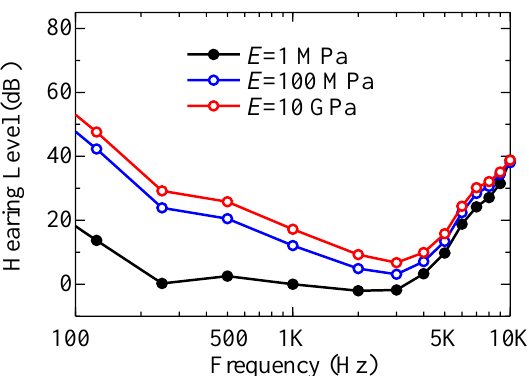
Figure 10. Estimation of the hearing level of the whole auditory system, including the properties of the outer, middle, and inner ears, when the ear is healthy. The upper graph shows the sound pressure level at the oval window when a sinusoidal plane wave with a pressure level of 1 Pa was excited at the pinna [42,43]. The middle graph shows the displacement of the basilar membrane when the pressure levels estimated above were used for sound wave excitation at the oval window. The lower graph presents the hearing level of the whole human auditory system. The result is expressed in “dB”, normalized at 1000 Hz, and redrawn so as to be compared to the general audiogram.